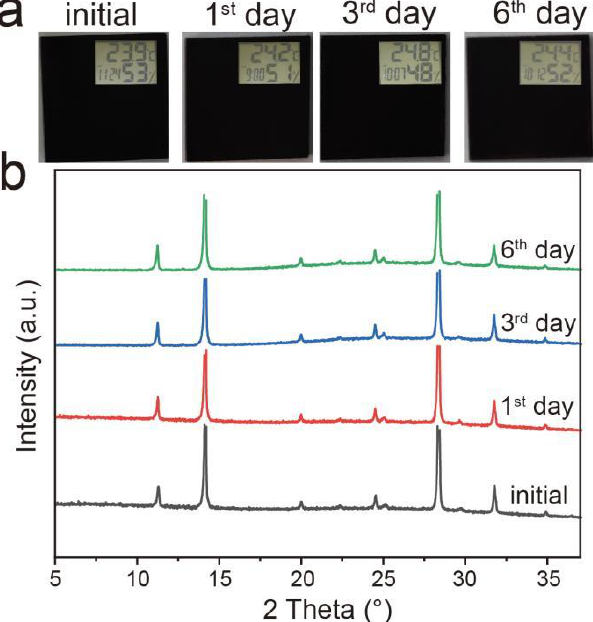
Figure 5. Time-dependent photographs ( a ) and XRD patterns ( b ) of 1D/3D PyPbI 3 /FACs perovskite film. Insets in ( a ) show the measured surroundings, including temperature and humidity.